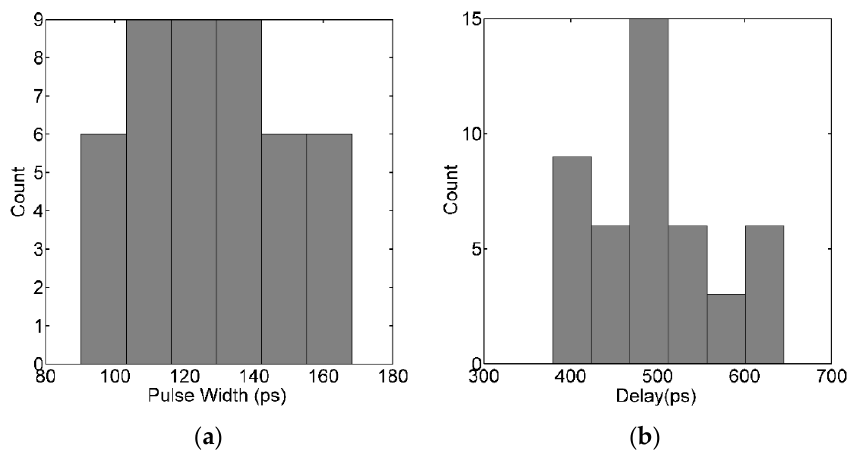
Figure 11. The process corner simulation result of the quenching circuit: ( a ) t width ; ( b ) t delay .